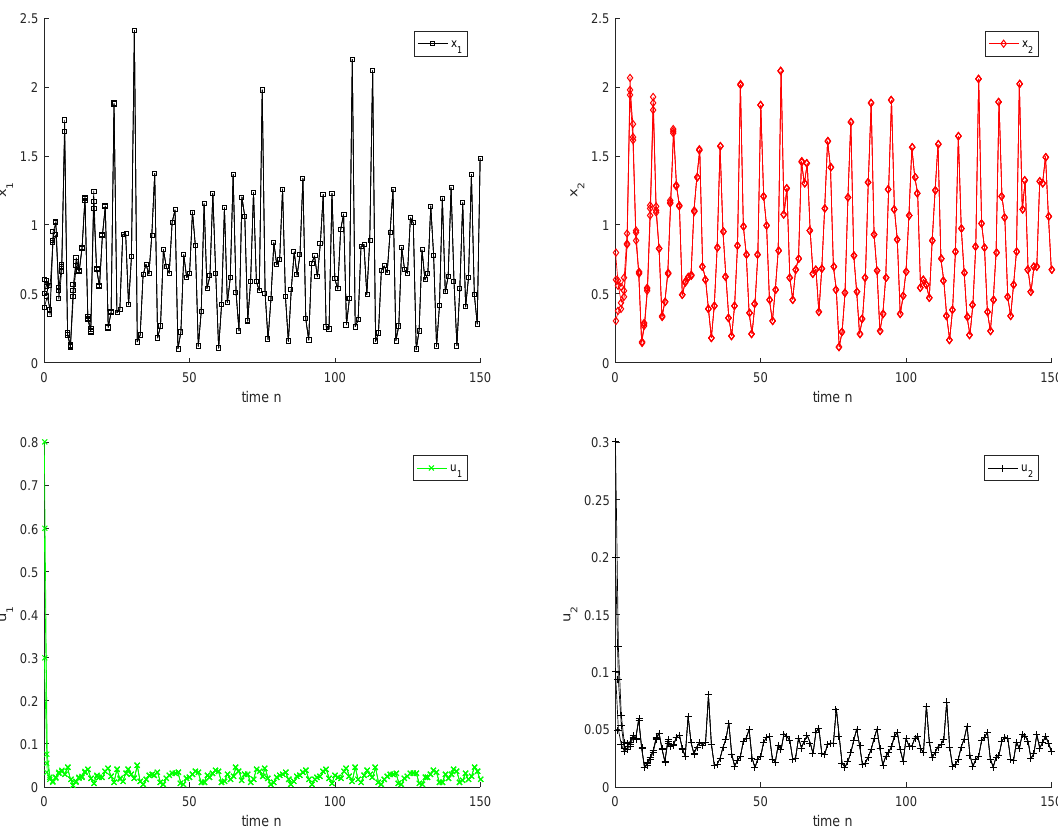
Figure 1: Dynamic behaviors of the solutions ( x 1 ( k ), x 2 ( k ), u 1 ( k ), u 2 ( k )) of system (56) with the initial conditions ( x 1 ( θ ), x 2 ( θ ), u 1 ( θ ), u 2 ( θ )) = (0.5, 0.3, 0.2, 0.1), (0.4, 0.6, 0.1, 0.3) and (0.6, 0.8, 0.3, 0.2) for θ = −2, −1, 0,